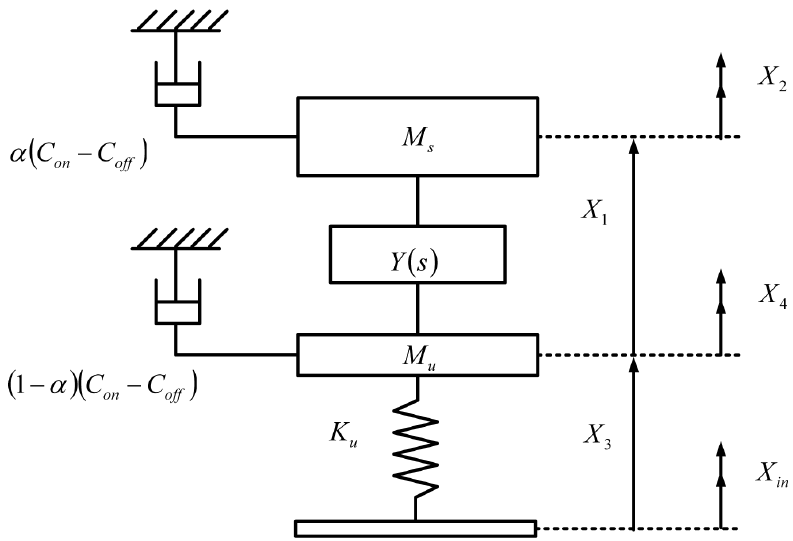
Fig. 2. A quarter-car model with a semi-active